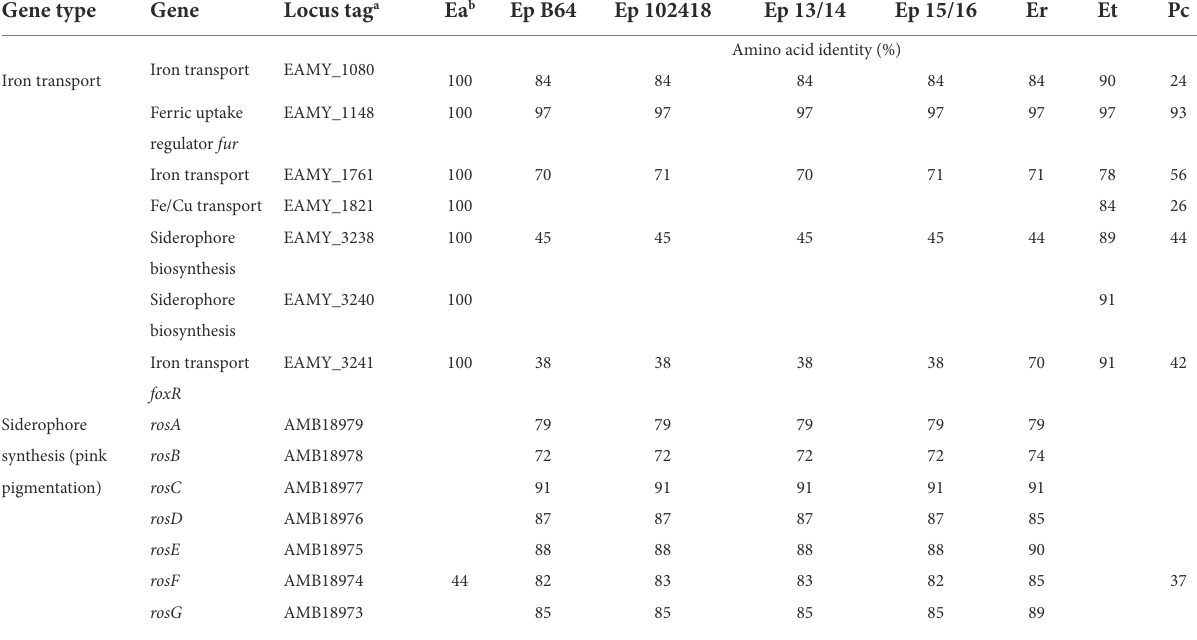
TABLE 6 Iron transport and pink pigmentation production in Erwinia persicina